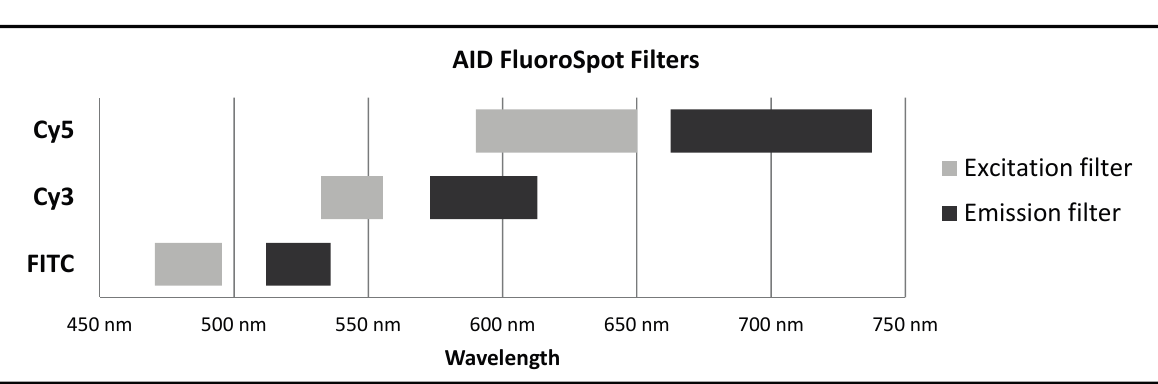
Figure 4. Excitation and Emission ranges for selected narrow band filters. A selection of narrow band filters as used in the AID Imaging Analyzer for the evaluation of